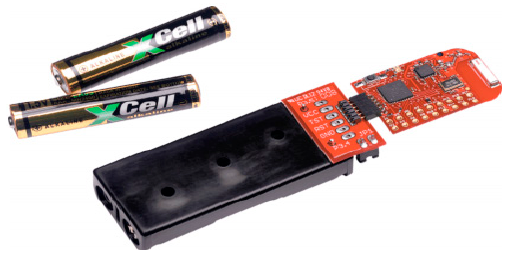
Figure 3. eZ430-RF2500T wireless node.